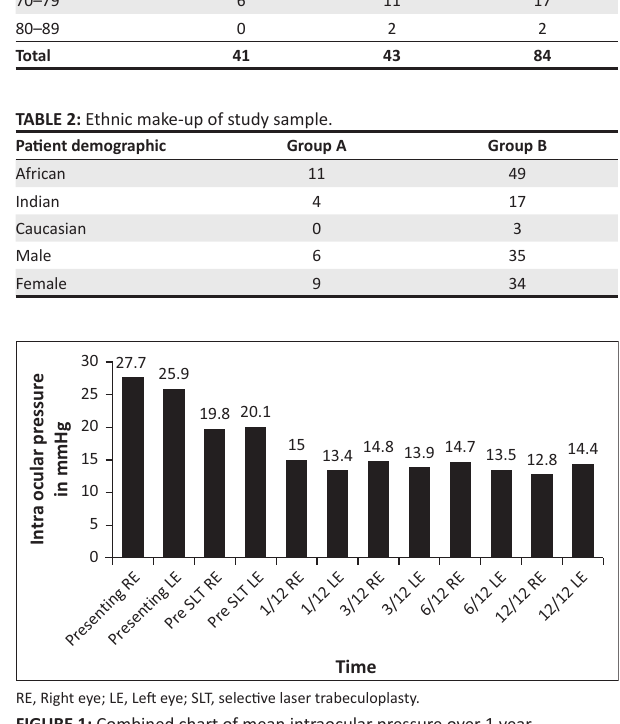
FIGURE 1: Combined chart of mean intraocular pressure over 1 year.